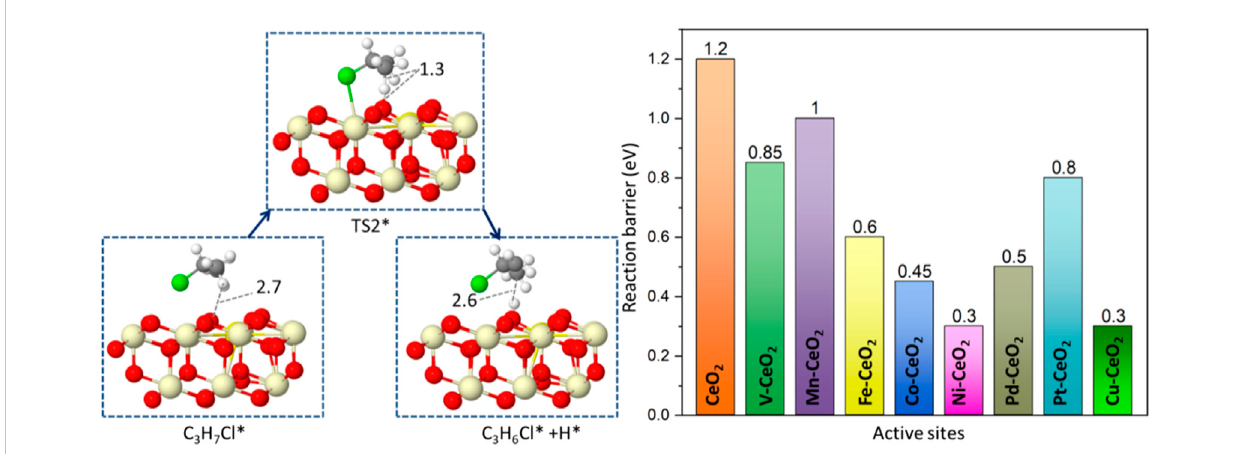
FIGURE 6 Reaction path and reaction barrier for the removal of the second H atom from C 3 H 7 Cl* with the Gibbs free energy barriers (TS2) of all catalytic